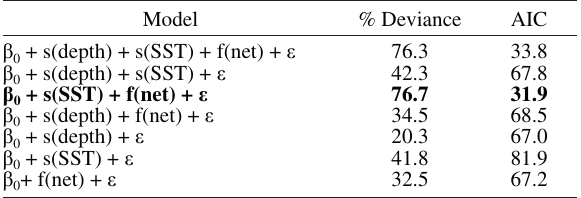
Table 4. – GAM for discarded species (biomass index). β intercept, s(depth) is a smoothing effect associated with the depth